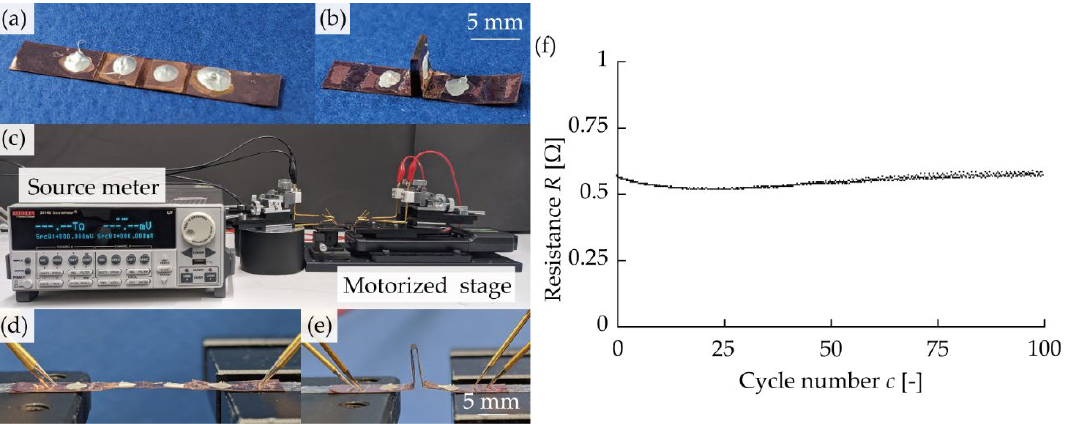
Figure 4. Evaluation of the repetitive deformation resistance. ( a ) Specimen before self-folding. ( b ) Specimen after self-folding. ( c ) Experimental setup. ( d ) Specimen during extension. ( e ) Specimen during contraction. ( f ) Change of the electrical resistance in 100 cycles.